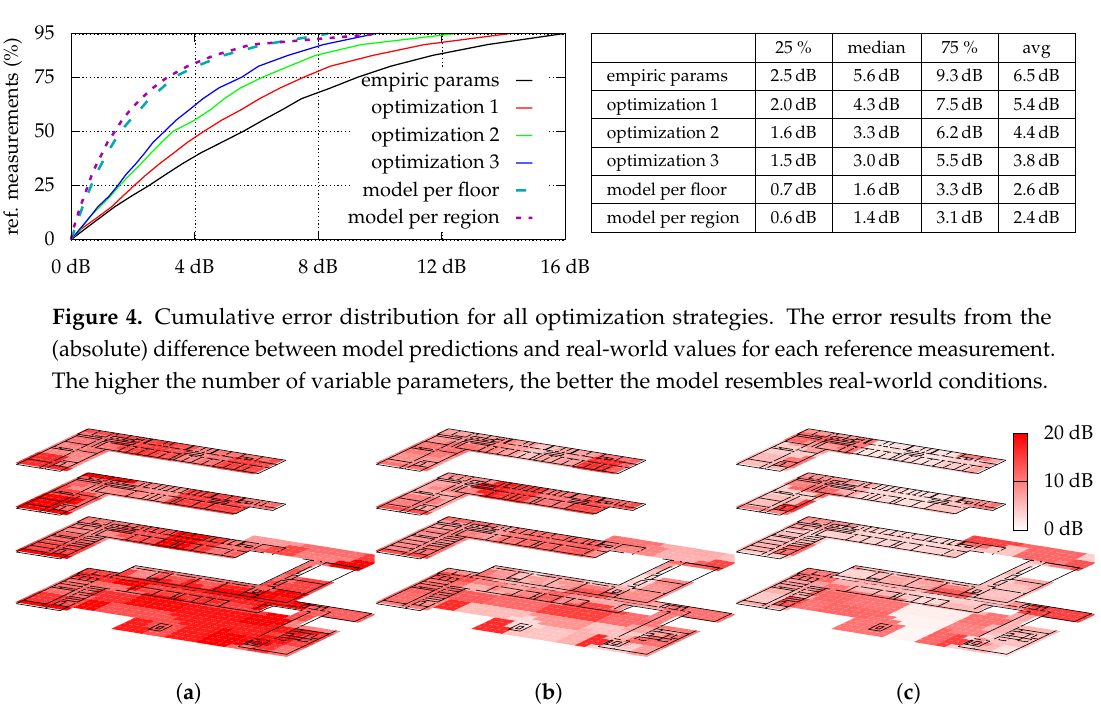
Figure 3. Measurable signal strengths of a testing AP (black dot). While the signal diminishes slowly along the corridor (wide, black rectangle), the building’s metalized windows (dashed, grey lines) between the indoor-region (grey) and the outdoor-region (green) attenuate the signal by over 30dB (small, black rectangle).